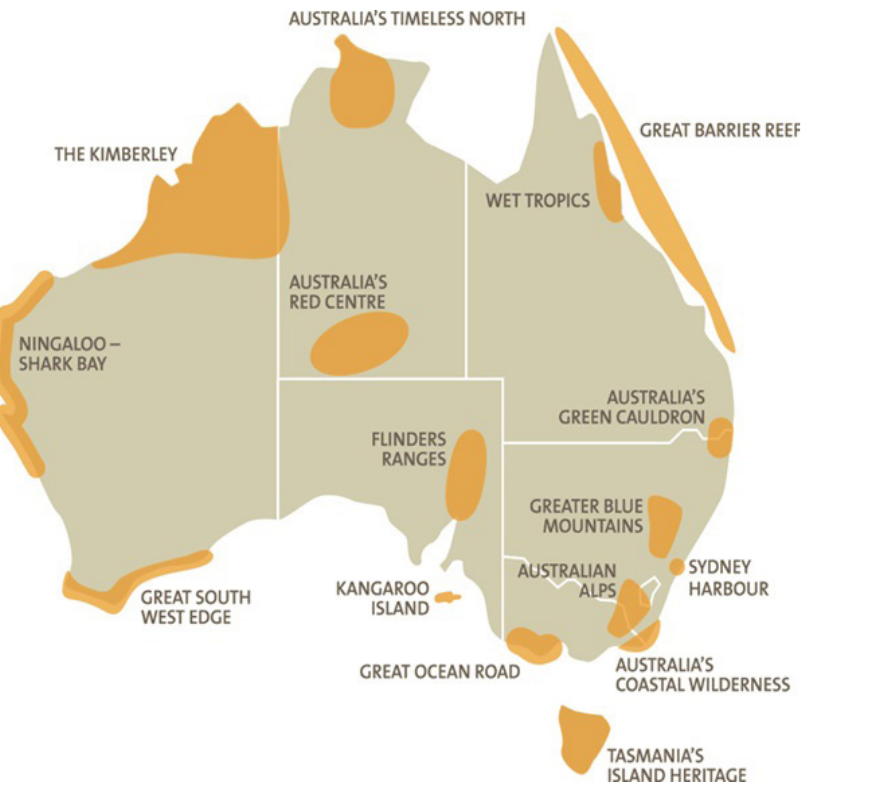
Figure 2. Australia’s National